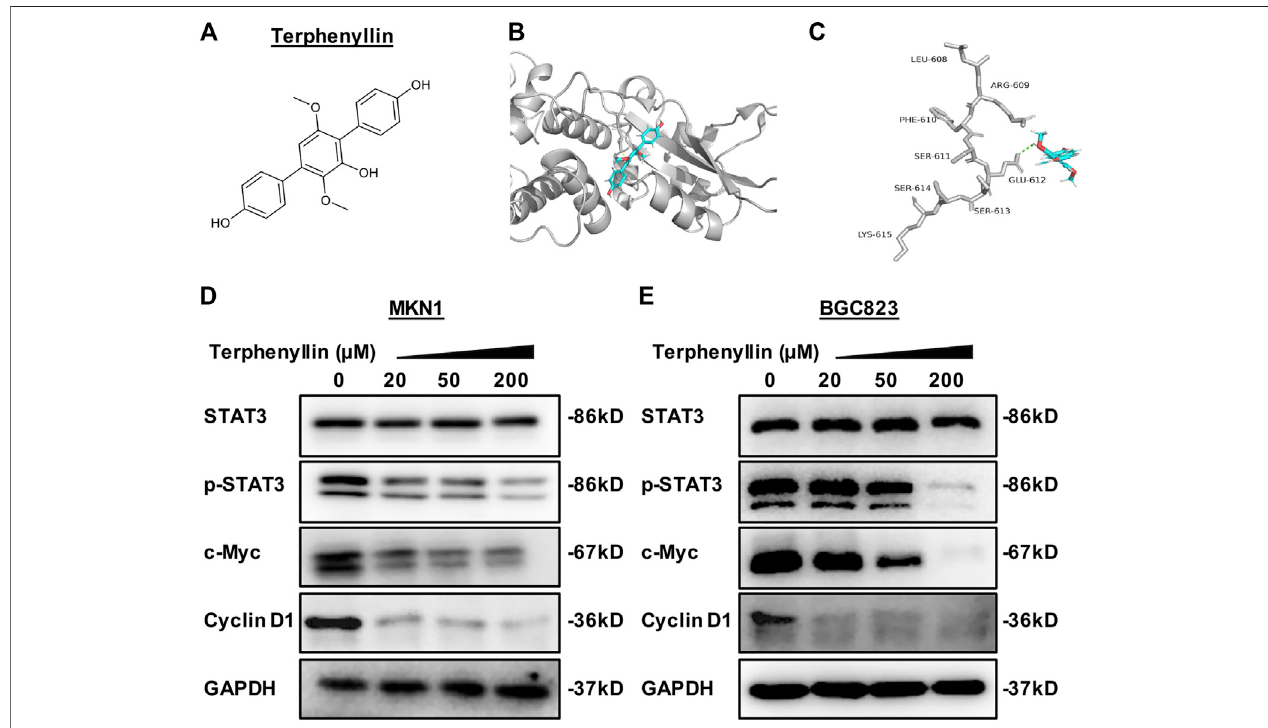
FIGURE 1 | Terphenyllin binds to STAT3 to reduce the expression level of p-STAT3 and inhibit the STAT3 signaling pathway. (A) The chemical structure of terphenyllin. (B,C) The proposed binding mode of terphenyllin and STAT3. (D,E) MKN1 and BGC823 cells were treated with terphenyllin at the speci fi ed concentration for 24 h, and the levels of various proteins were detected by western blot